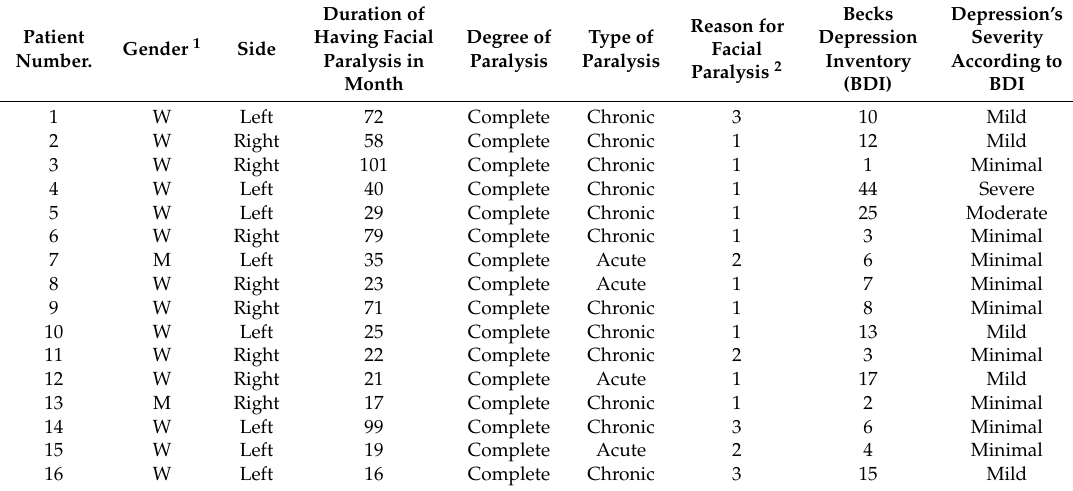
Table 1. Characteristics of the facial nerve paralysis patients in this